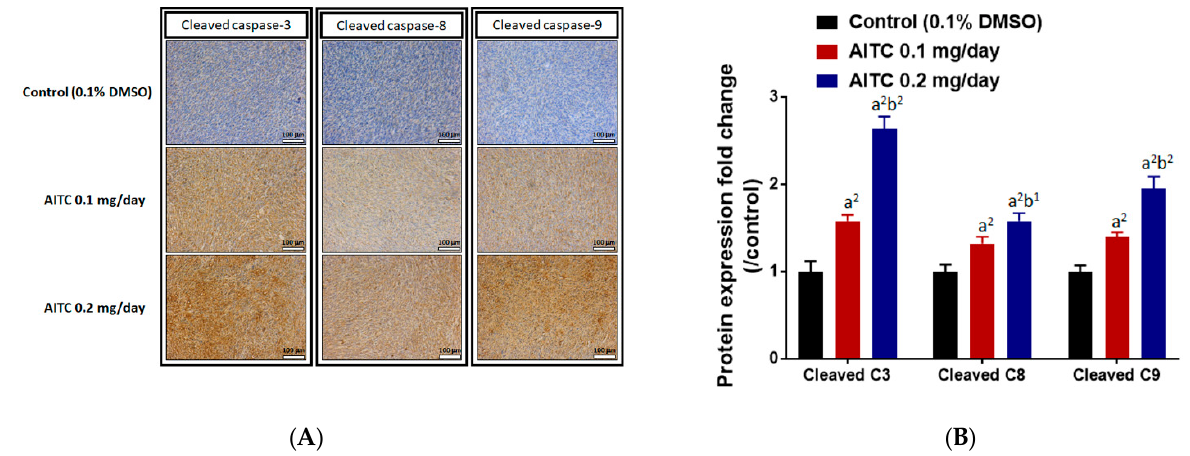
Figure 6. AITC induced the expressions of apoptosis-related proteins. Tumors were isolated from each group and further examined by IHC staining. The IHC staining images of cleaved caspase-3, -8, and -9 on the mouse tumors were observed by microscope at 100 times magnification ( A ). The quantification data of cleaved caspase-3, -8, and -9 expressions are presented ( B ). (a 2 p < 0.01 vs. control; b 1 p < 0.05, b 2 p < 0.01 vs. AITC 0.1 mg/day). Each section was imaged with 3 independent fields and quantified. (Scale bar = 100 µ m, with 200 ×